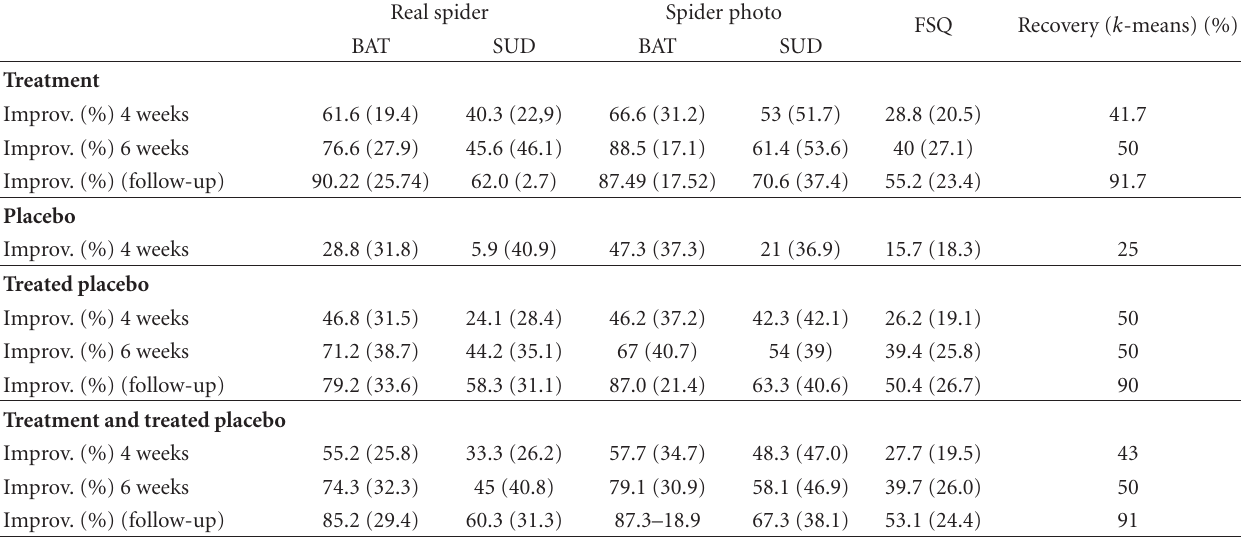
Table 2: Improvement of the BAT, SUDS, and FSQ scores in Table 1 expressed in percentages. The percentage of improvement was calculated from Table 1 by dividing the measurement by the initial score. The last column exhibits the percentage of patients that migrated to the condition of normal subjects, according to the k -means algorithm. According to this, in six months, 91.7% of the treatment-group subjects became